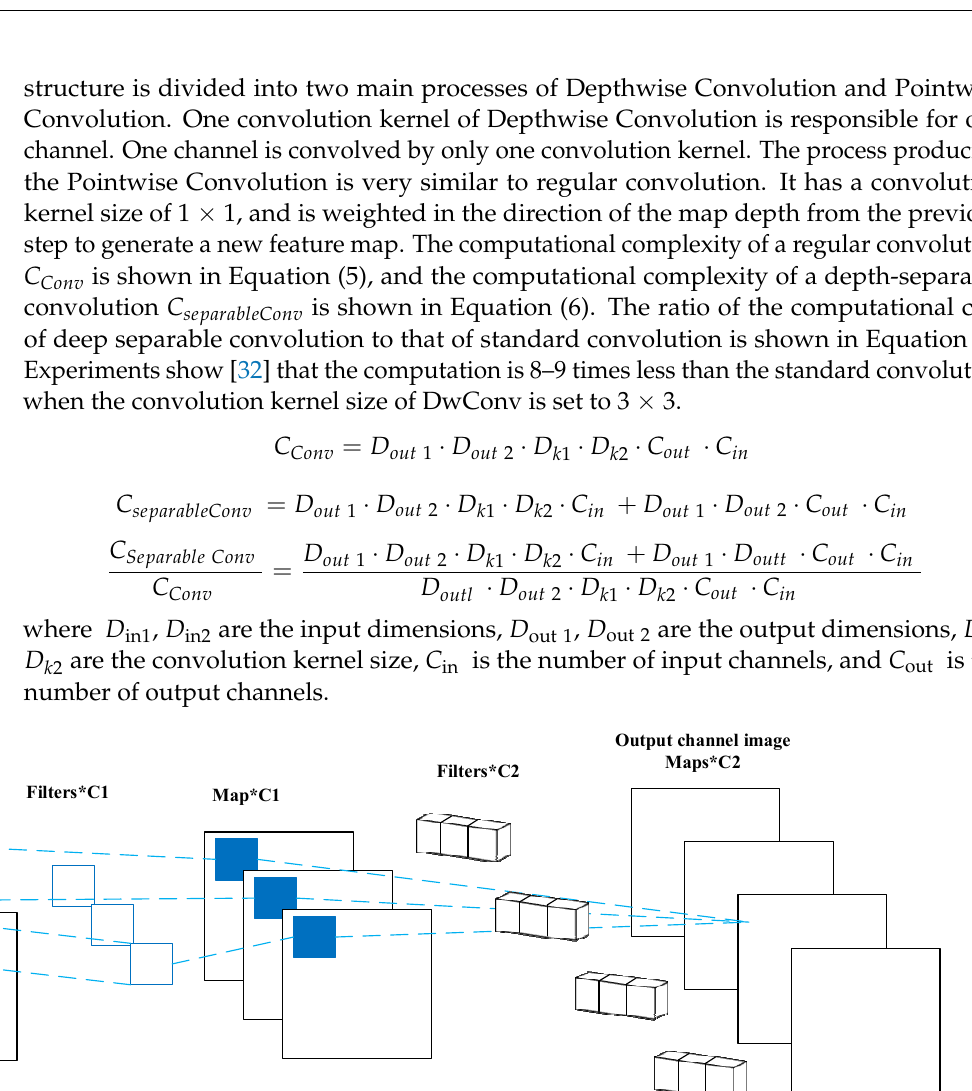
Figure 5. AC3Ghost module Structure.